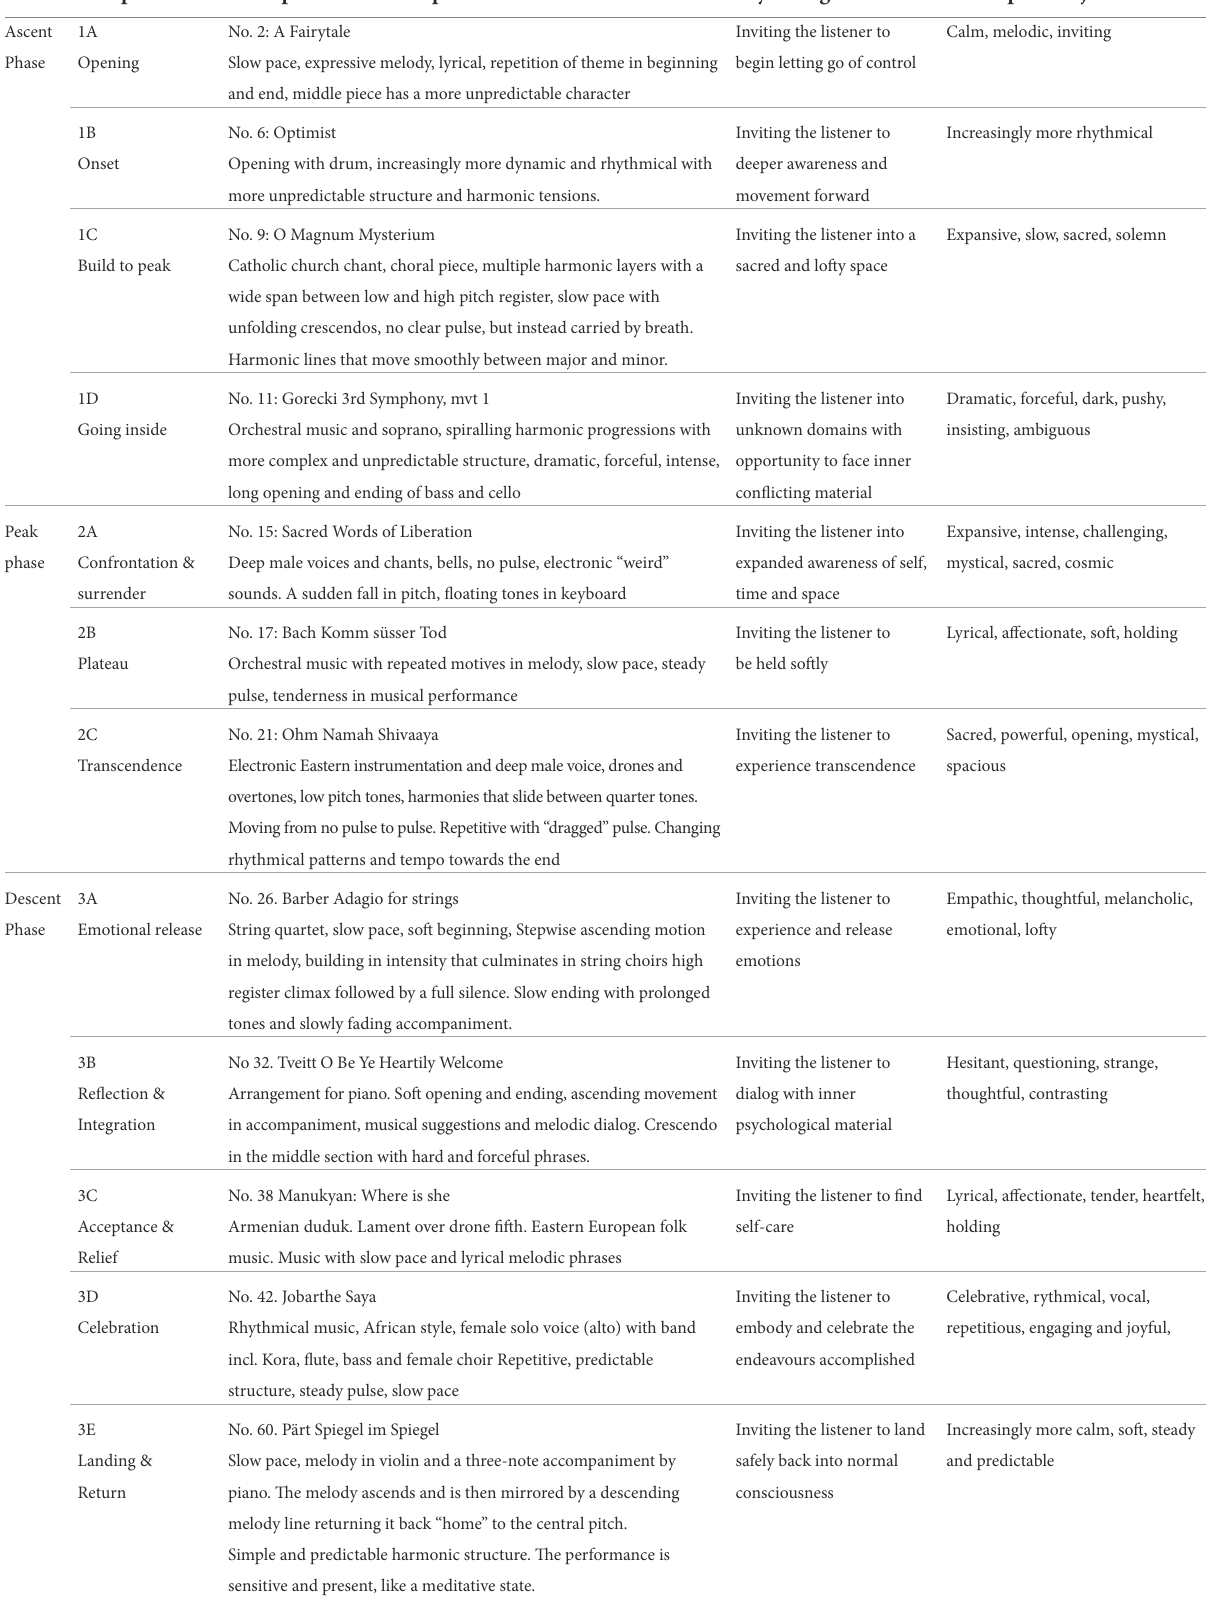
TABLE 1 Phases and sub-phases of the Copenhagen Music